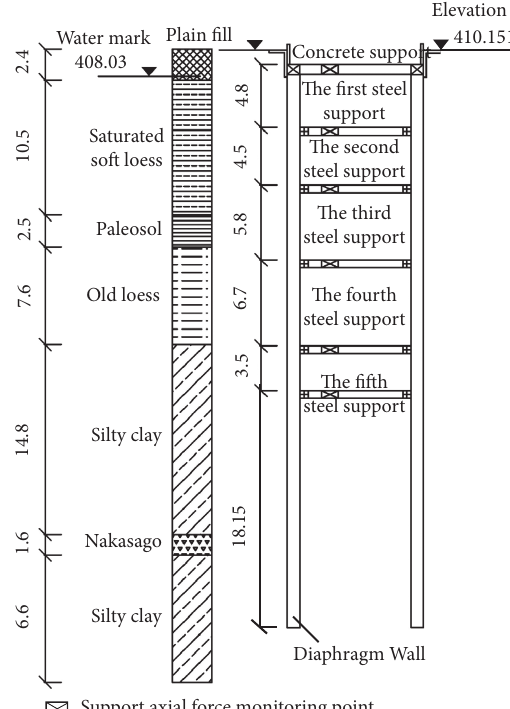
Figure 4: Survey point layout (unit: m).